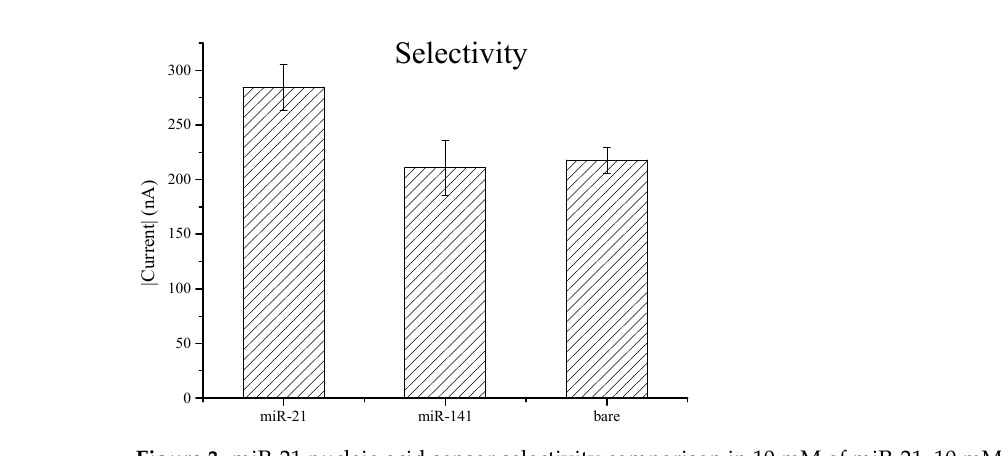
Figure 3. miR-21 nucleic-acid sensor selectivity comparison in 10 mM of miR-21, 10 mM of miR-141, and bare electrode using chronoamperometry.